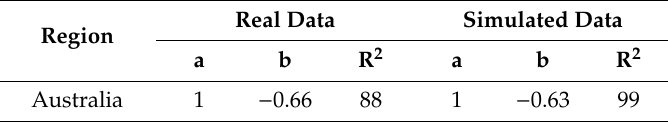
Table 1. Properties of the constant N e spatial dependence